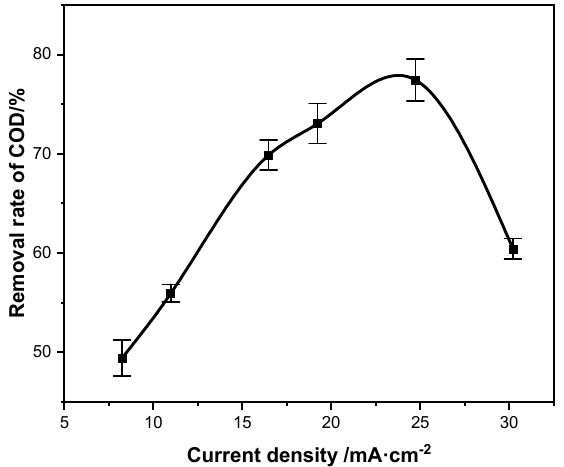
Figure 4. Effect of current density on mixed wastewater COD removal rate (anode material: Fe, cathode material: Stainless steel, pH: 7.1, electrolysis time: 50 min).